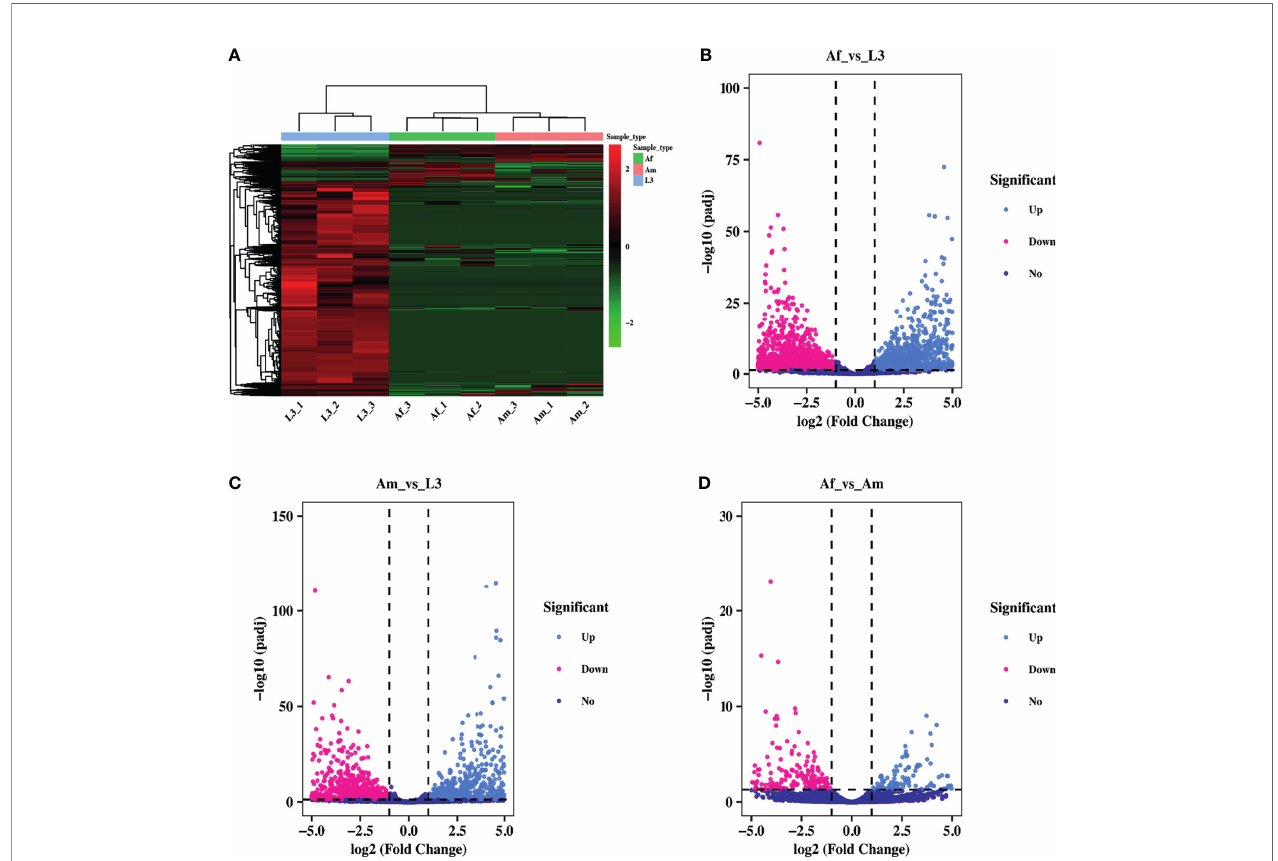
FIGURE 2 | Differential expression pattern of circRNAs in H. contortus . (A) Hierarchical clustering analysis of differentially expressed circRNAs across L3, Af, and Am samples. The expression values were represented in different colors. Red strip represented high relative expression and green strip indicated low relative expression. (B – D) The volcano plot for differentially expressed circRNAs in Af_vs_L3, Am_vs_L3, Af_vs_Am comparisons. The volcano plot was constructed using log2 (Fold Change) and padj. light blue points: up-regulated circRNAs; red points: down-regulated circRNAs; purple points: no difference. The cut-off criterion was set as Fold Change ≥ 2 and padj<